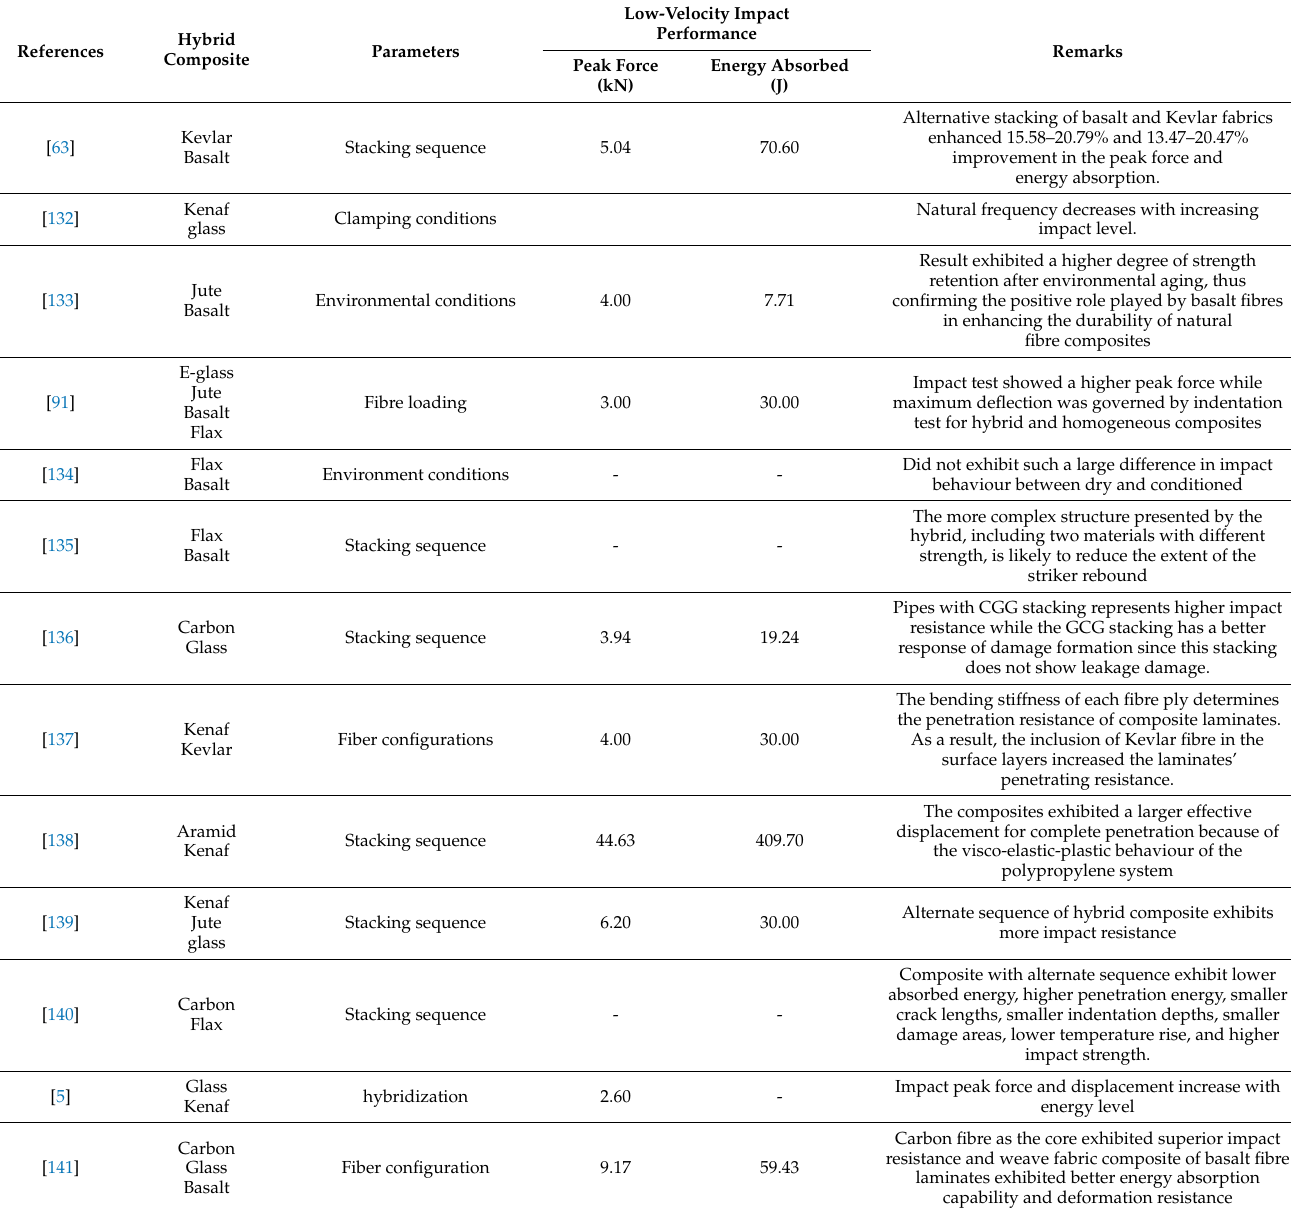
Table 9. Reported research on perforation resistance of hybrid composite